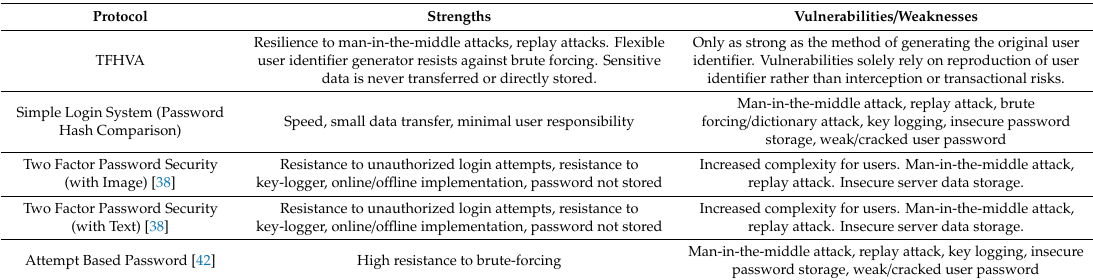
Table 4. Protocol